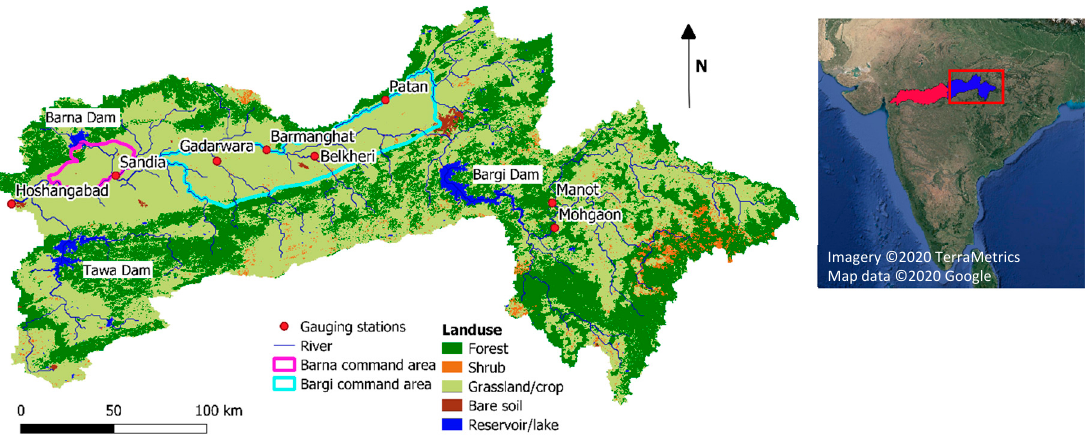
Figure 1. Index map of Upper Narmada basin